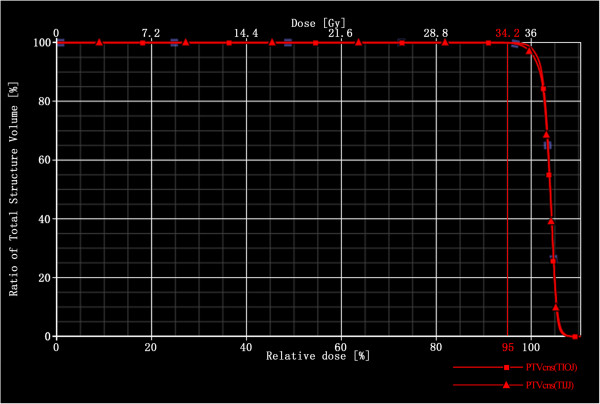
Dose volume histogram (DVH) comparison of target coverage. DVH of a representative plan comparing target coverage between the TIOJ plan and the TIJJ plan. The target coverage of both plans meet the initial goal for the target volume coverage.